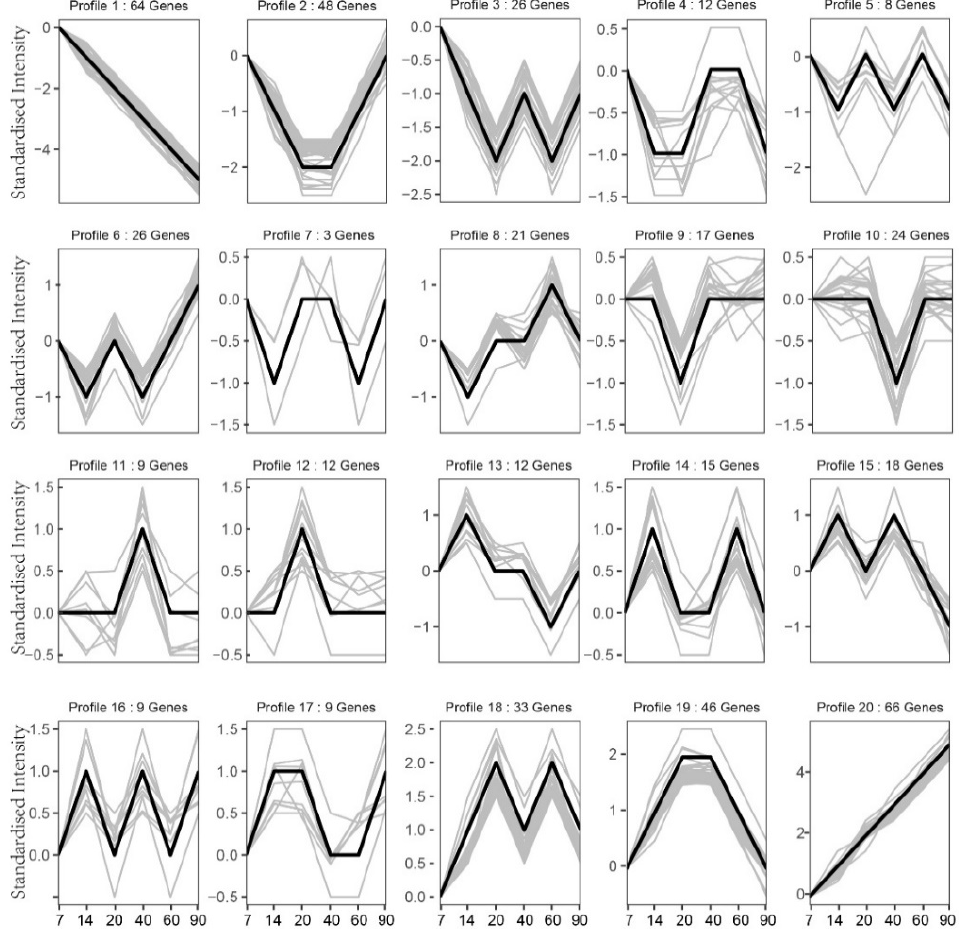
Figure 4. Expression patterns of the candidate genes within the QTL regions. Profile 1–20 represent different expression patterns of the clusters of candidate genes within the union sets of QTL regions on R4 and R7 during the developmental process (7 d, 14 d, 20 d, 40 d, 60 d, 90 d). The number of genes is displayed at the top of each panel.